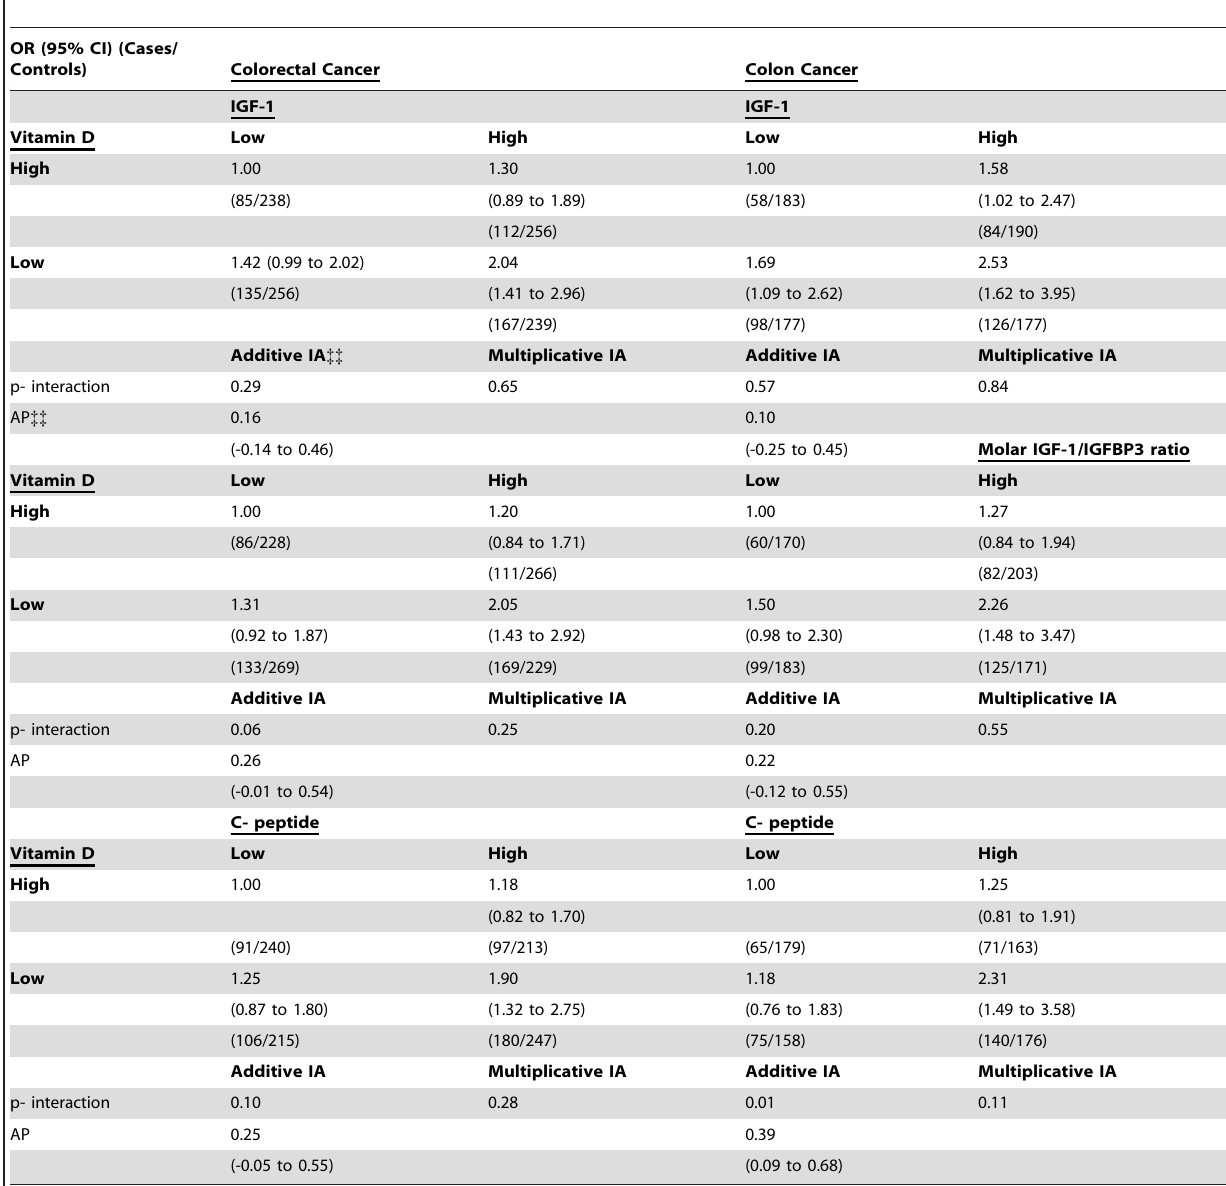
Table 3. Multivariable adjusted ORs and 95% confidence intervals of colorectal and colon cancer by median levels of IGF-1, C- peptide, IGF-1/IGFBP3 ratio and vitamin D, HPFS and NHS combined.